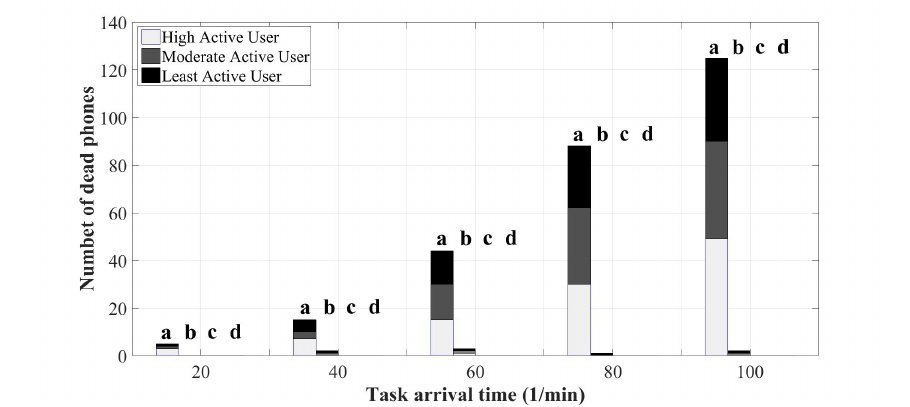
Figure 14. Number of dead phones: ( a ) mobile crowd-sensing benchmark; ( b ) SOBER-MCS with (cid:60) = 10%; ( c ) SOBER-MCS with (cid:60) = 15%; and ( d ) SOBER-MCS with (cid:60) =